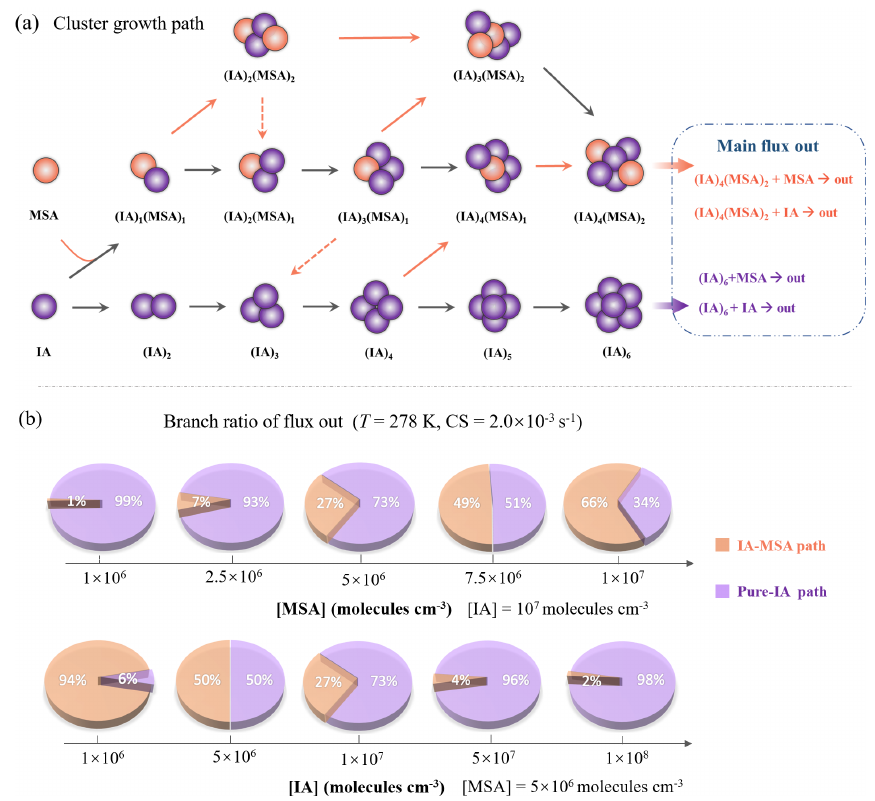
Figure 5. (a) Main cluster growth pathway of the IA-MSA nucleating system at T = 278K, CS = 2 . 0 × 10 − 3 s − 1 , [IA] = 10 7 , and [MSA] = 5 × 10 6 molec.cm − 3 . The black and orange arrows refer to the pathways of colliding with IA and MSA, respectively, where the dashed arrows indicate the evaporation of MSA. (b) Branch ratio of IA-MSA (orange pieces) and pure-IA (purple pieces) growth pathway under varying [MSA] (10 6 –10 7 molec.cm − 3 ) and [IA] (10 6 –10 8 molec.cm − 3